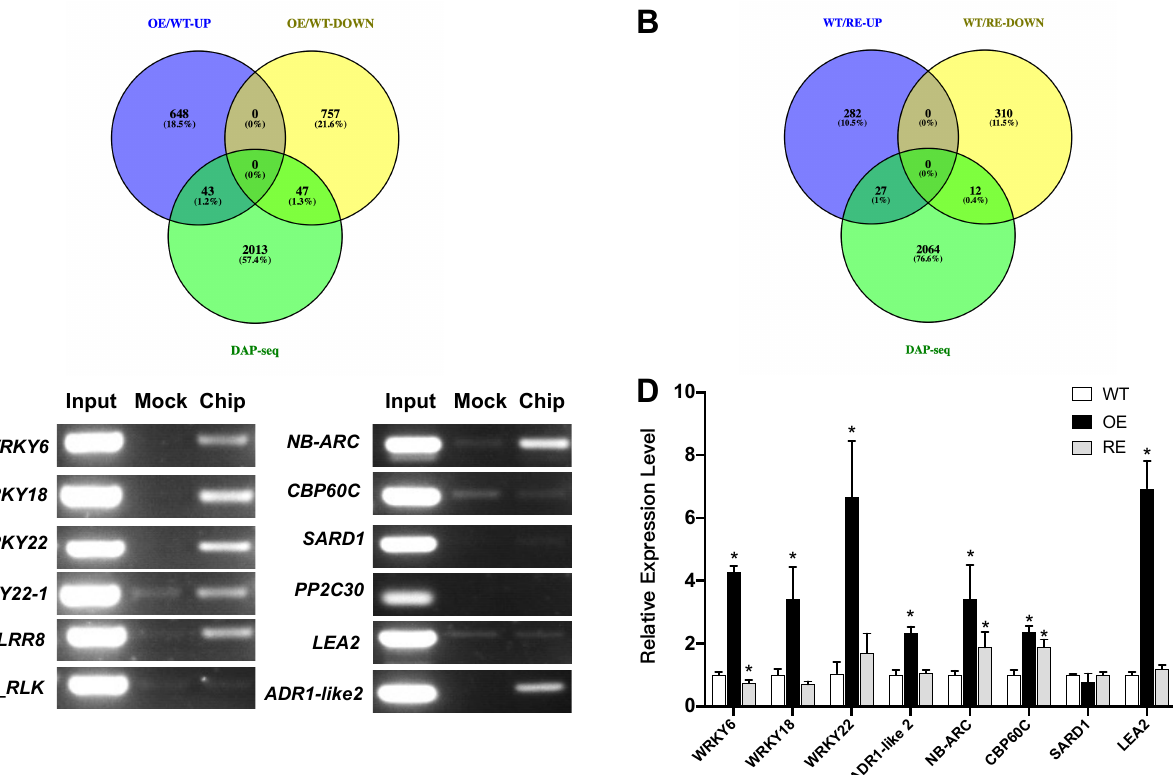
Figure 7. Validation of downstream target genes of PsnWRKY70 gene. ( A ) Venn diagram of upregu- lated genes between RNA-seq and DAP-seq. ( B ) Venn diagram of downregulated genes between RNA-seq and DAP-seq. ( C ) CHIP-PCR for downstream genes of PsnWRKY70 . ( D ) qRT-PCR of downstream genes of PsnWRKY70 ( n = 3, * p <